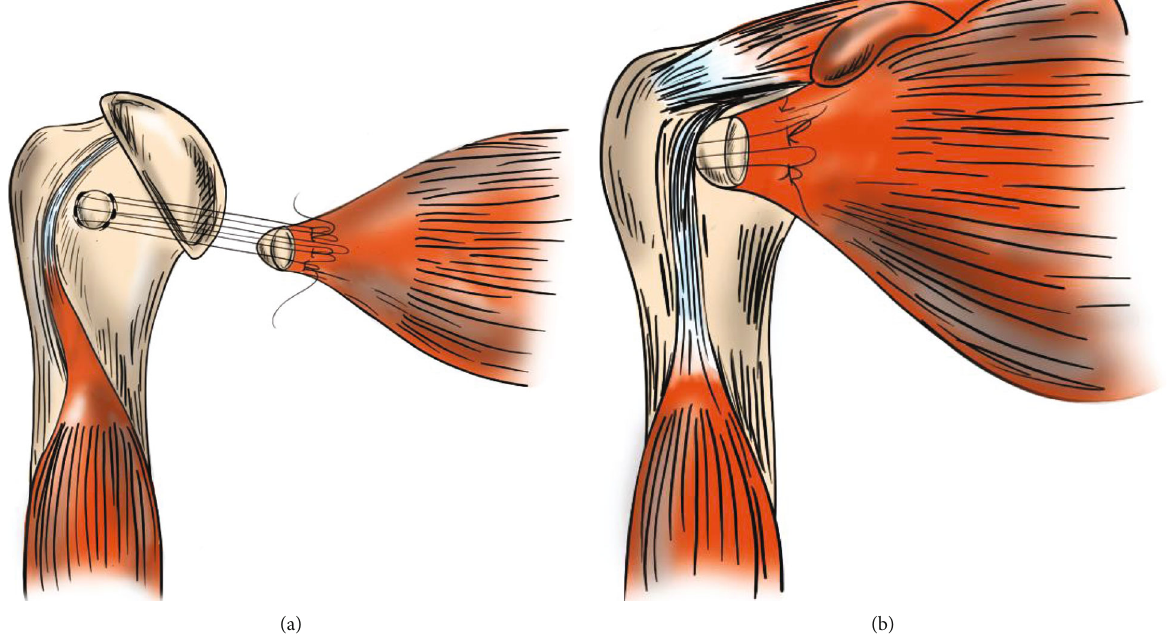
Figure 4: (a) Anteroposterior view of suture placement for avulsion fracture repair; (b) fi nished